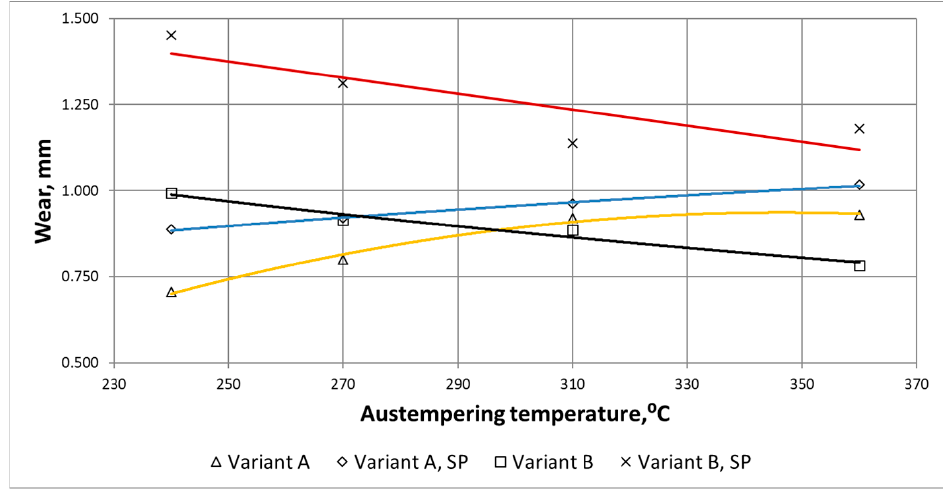
Figure 13. Waveforms of the wear parameter δ MAX as a function of the isothermal quenching temperature of ADI, determined for different variants of wear and dynamic treatment.